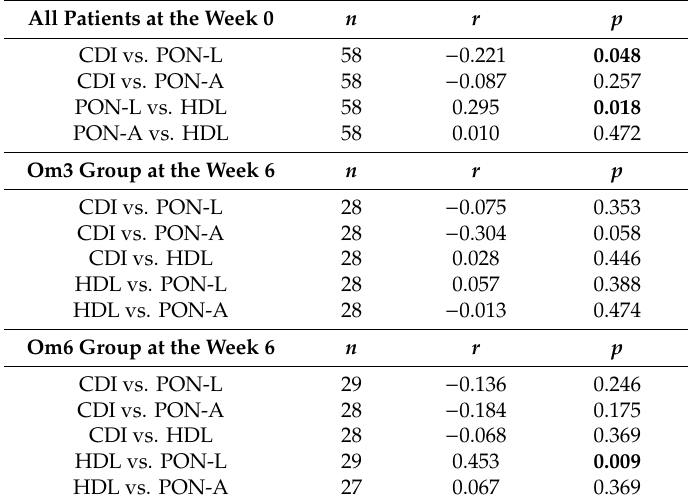
Table 3. Correlations between activity of PON-L and PON-A vs. CDI and